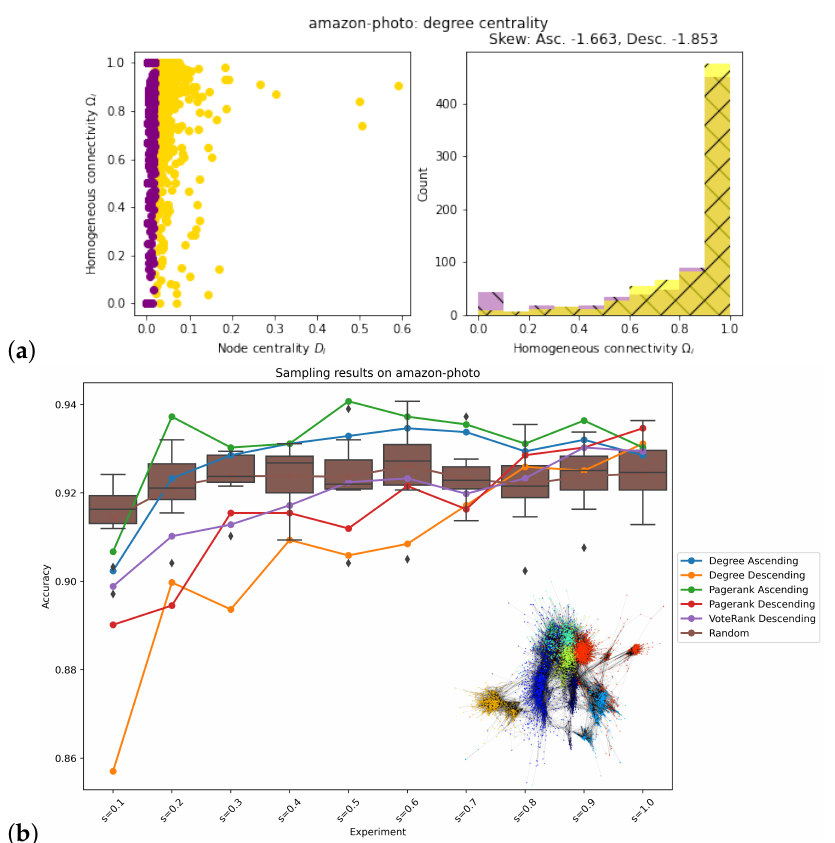
Figure A2. Panel ( a ) shows degree centrality plots where the left figure presents scatter plots of node degree centrality D i against node homogeneous connectivity Ω i on the training data of amazon- photo. The upper half of nodes according to their centrality are colored in yellow while the lower half is presented in purple. The histogram on the right visualizes the distribution of homogeneous connections. The skew for each subset’s distribution is annotated above the right graph. Panel ( b ) presents the sampling result on the training data of